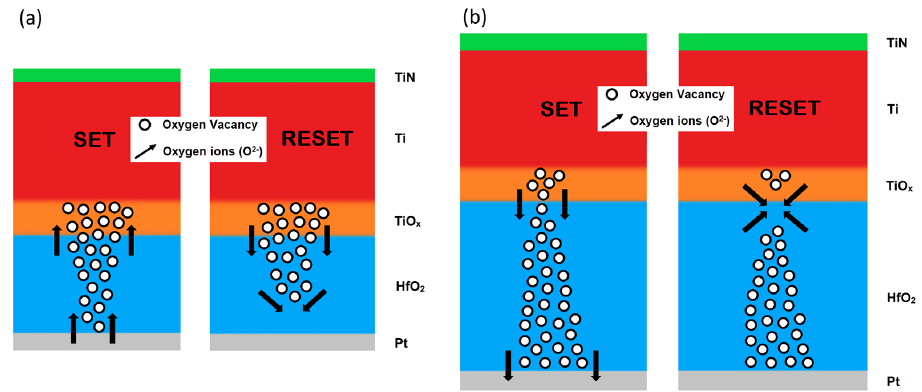
Figure 6. Proposed resistive switching mechanism for the ( a ) 8 nm and ( b ) 13 nm thick HfO 2 sam- ples.